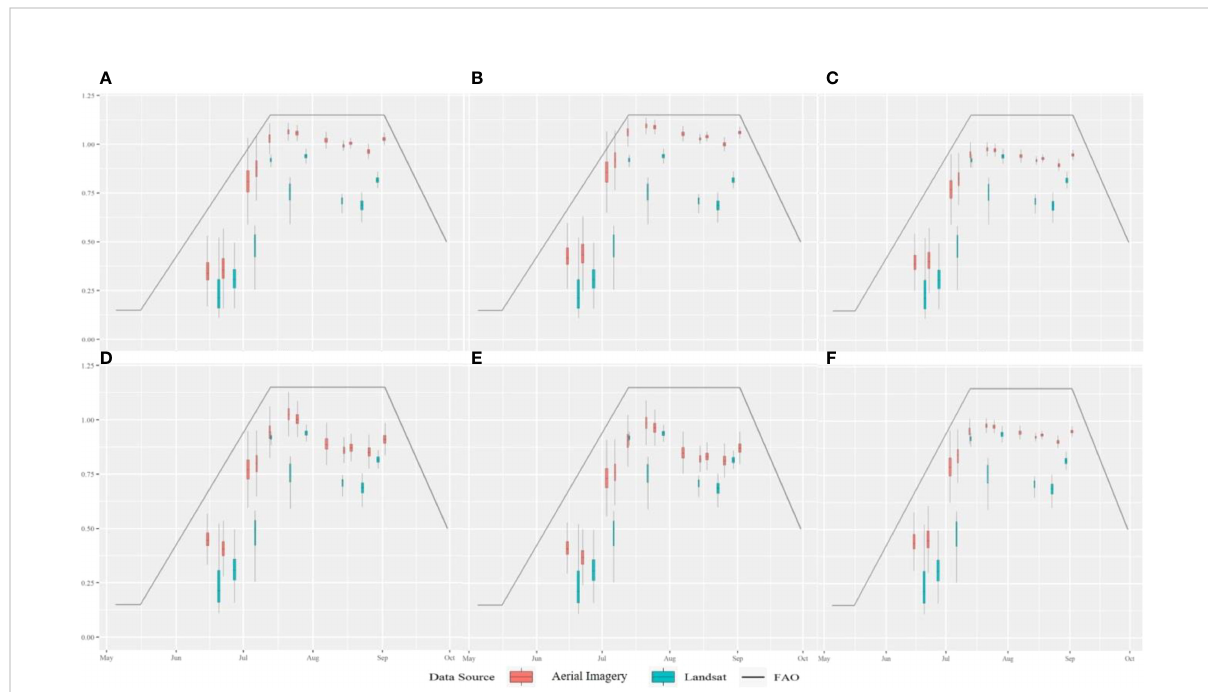
FIGURE 6 Total seasonal differences between the Aerial Imaging crop coef fi cients and the Landsat Fractional ET Data at the SWREC. Aerial Imaging crop coef fi cients were estimated from equations developed by (A) Kamble et al. (2013), (B) Bausch and Neale (1987), (C) Bausch and Neale (1987), (D) Bausch (1993), (E) Campos et al. (2017), and (F) Neale et al.,